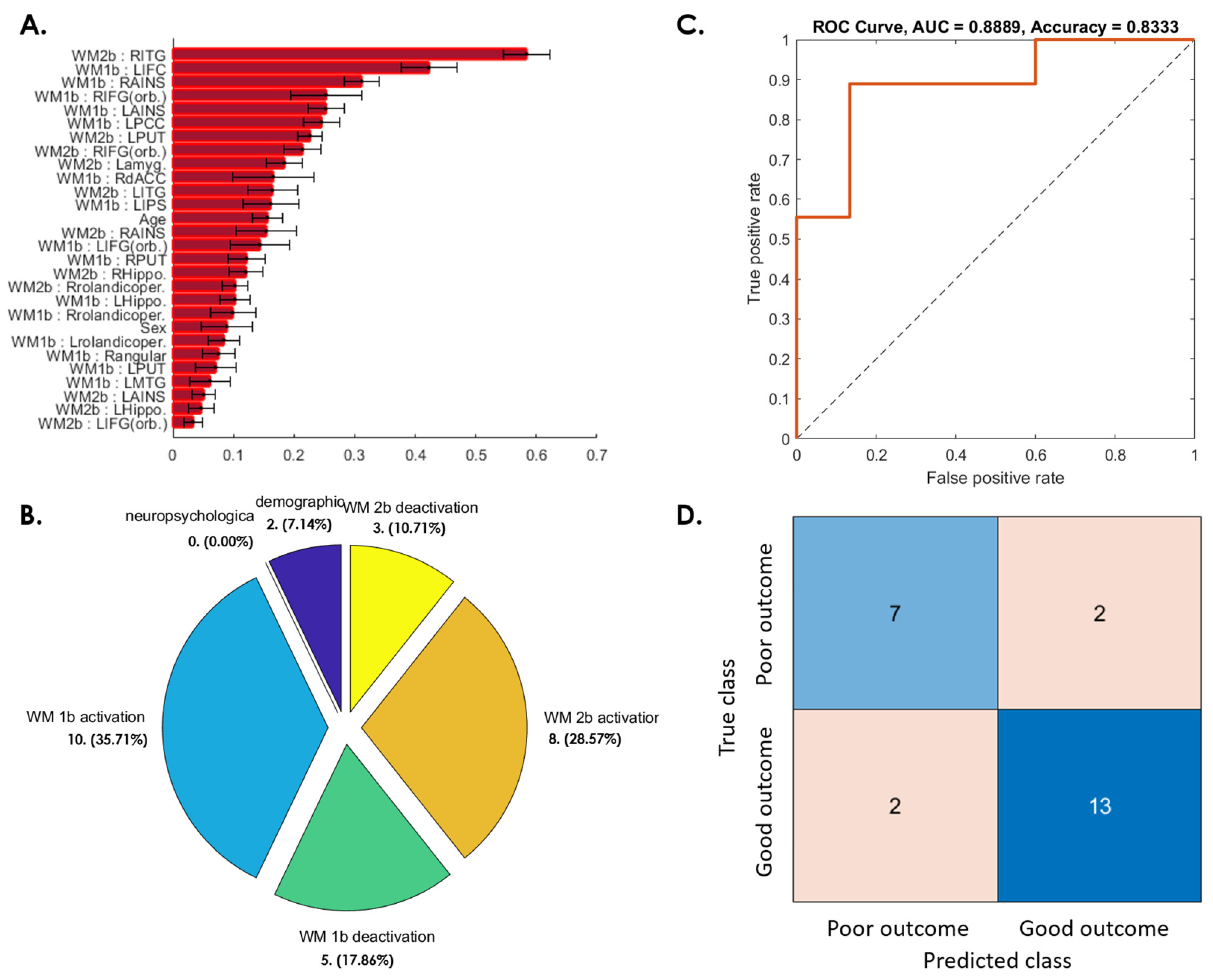
Figure 5. SVM predictive model for 37.5% of patients whose WM ability did not recover from the 6-month to 1-year follow-up. ( A ) The red bar graph and the corresponding error bar, respectively, represent the average and standard deviation of the discriminative feature weights among the 10 cross-validated SVM classifiers. ( B ) Profiles of the selected features for constructing the SVM classification model. None of the neuropsychological features were selected for this predictive model. ( C ) ROC curve of the selected feature to discriminate the “poor outcome group” from the “good outcome group”. ( D ) Confusion matrix to summarize the results of this binary classification